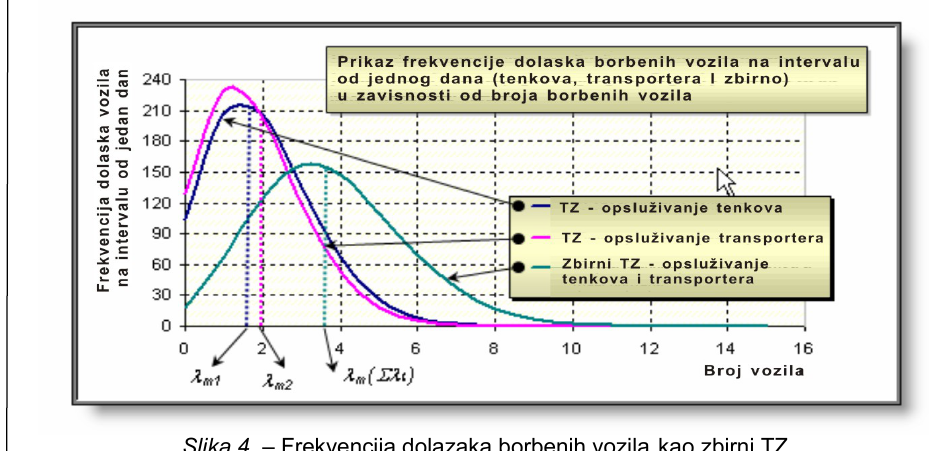
Figure 4 – Frequency of c/v arrivals as collective